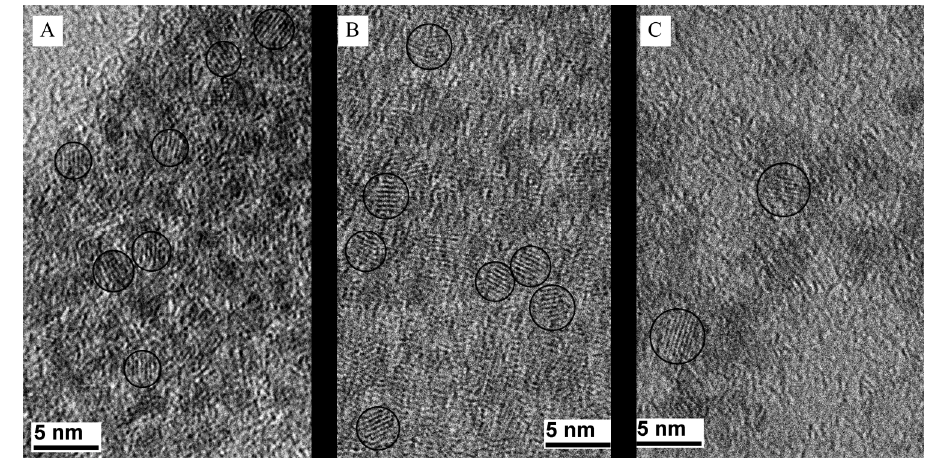
Figure 3. TEM images of CdS(2.5) ( A ), CdS(5.0) ( B ), and CdS(7.5) ( C ).